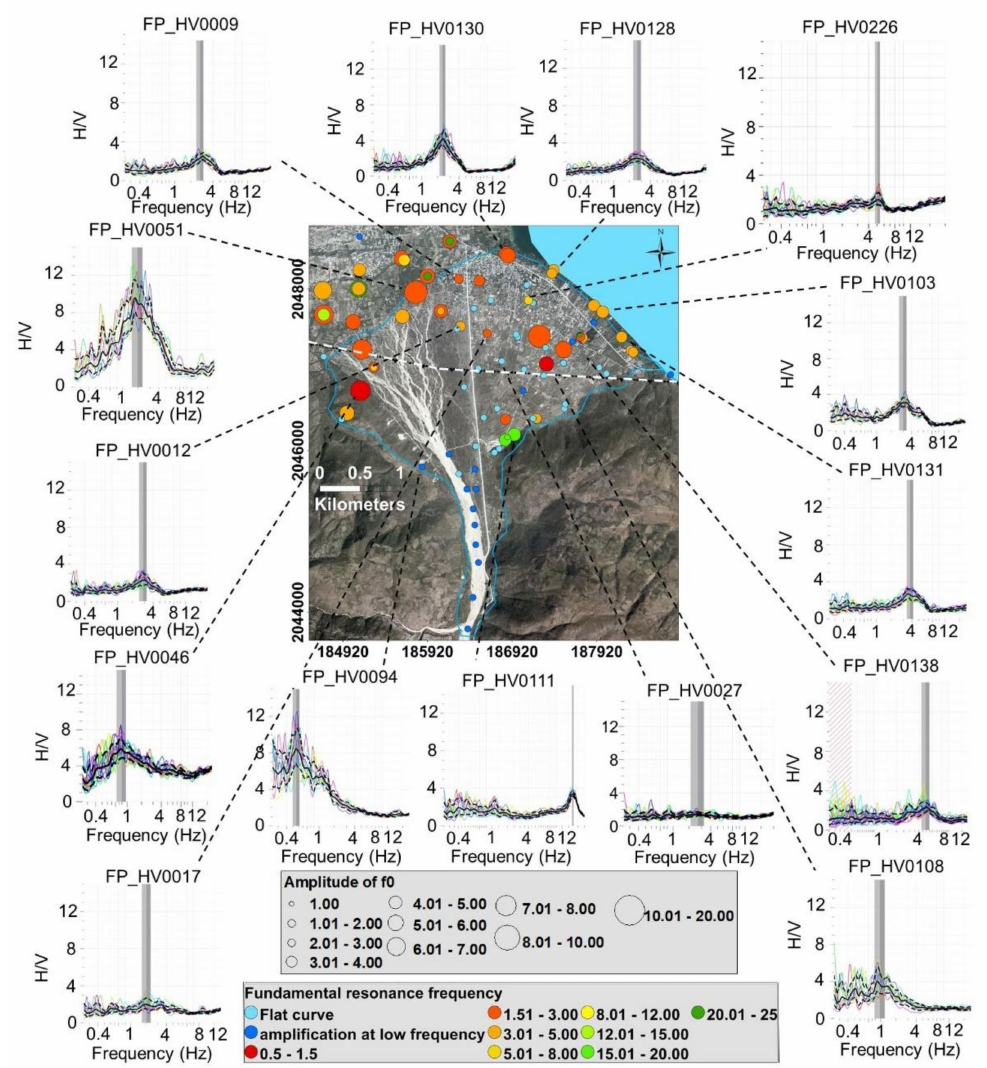
Figure 7. Examples of HVSR results obtained for ambient noise measurements completed on/near the alluvial fan. Circles on the central map indicate the resonance frequency, f0 (color), and amplitude of the f0 peak (size of